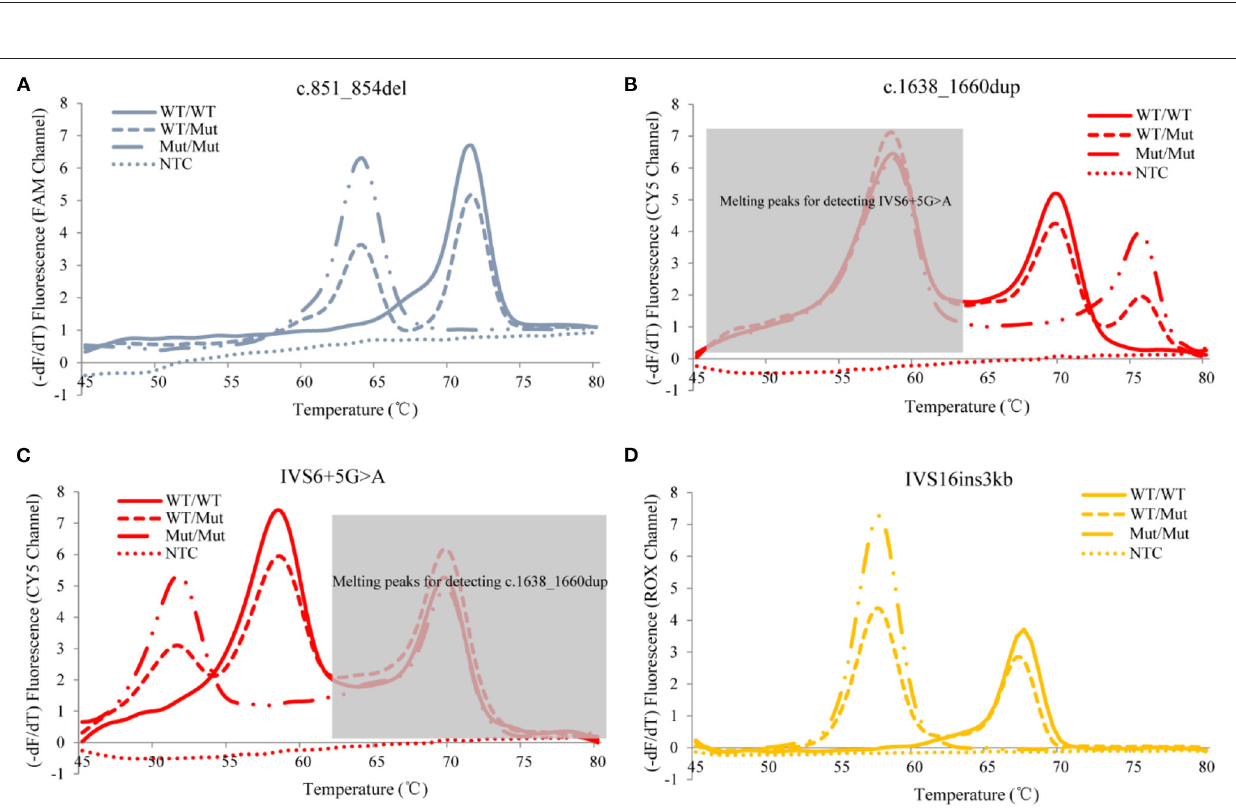
Frontiers in Pediatrics | www.frontiersin.org